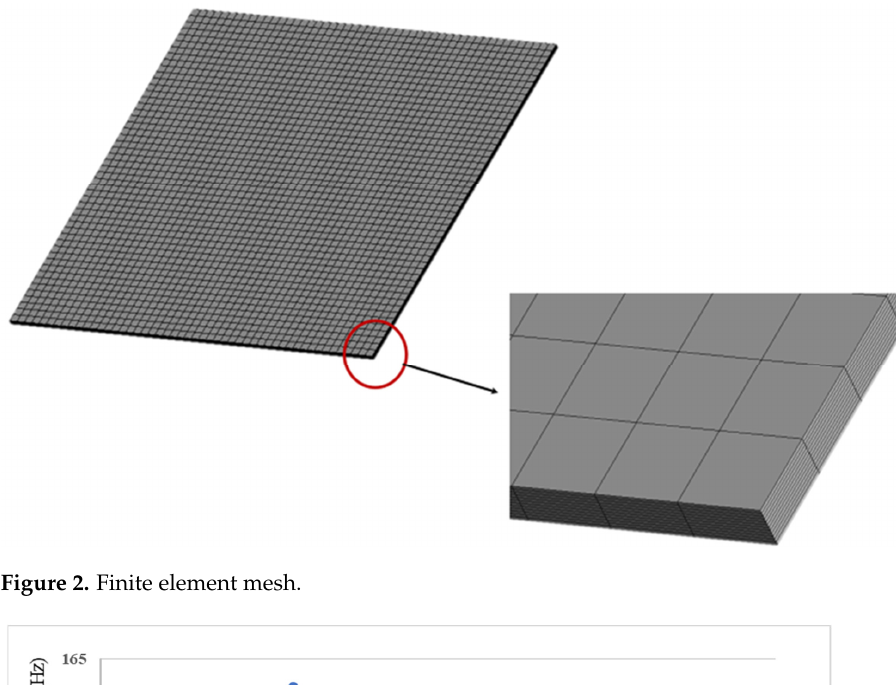
Table 1. Natural frequencies (Hz) of a simply supported composite laminate plate.